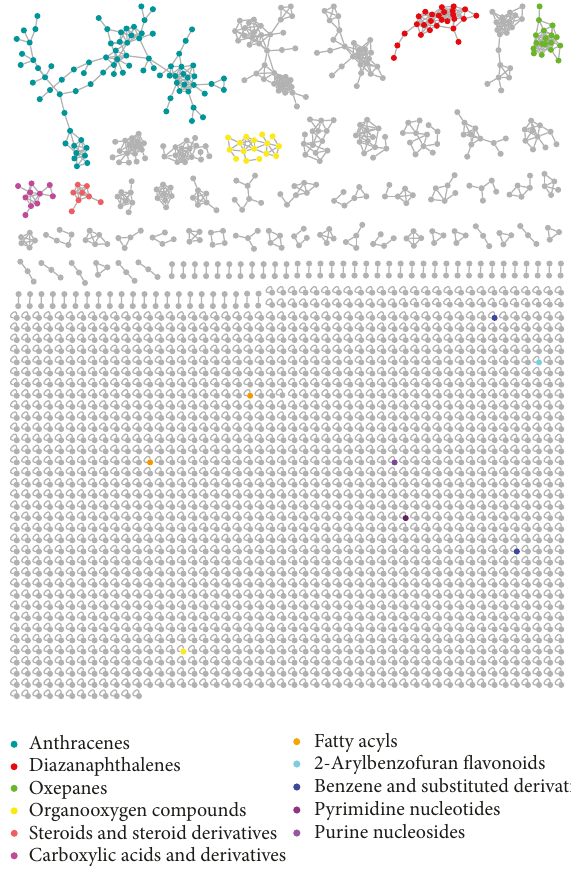
Figure 2: The entire MS/MS molecular network obtained from